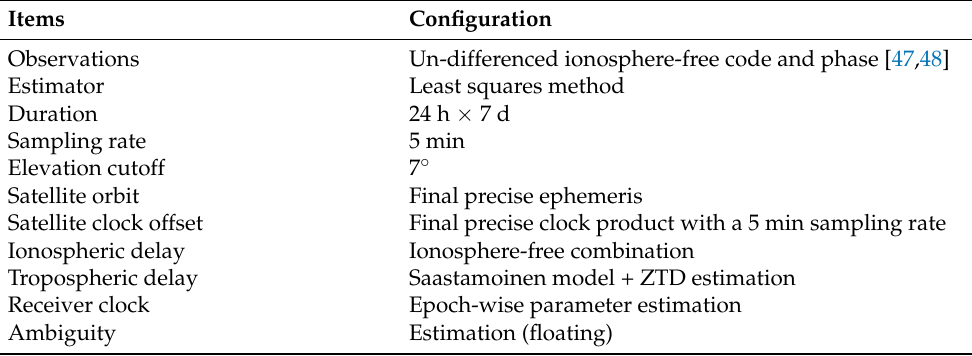
Figure 4. Distribution of IGS stations selected for PPP validation. Table 2. Post ‐ processing kinematic PPP configuration.